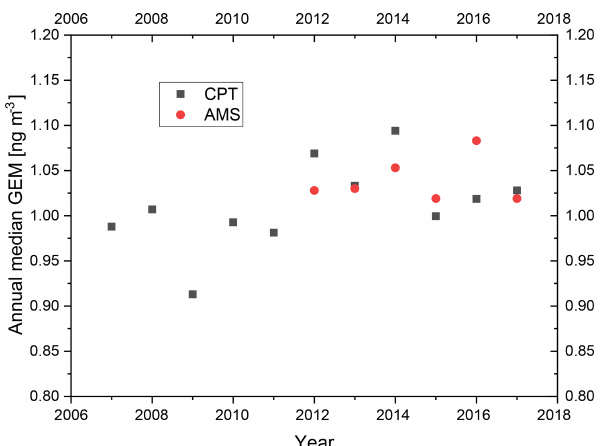
Figure 3. Annual median GEM concentrations at Cape Point (CPT) from March 2007 until December 2017 and at Amsterdam Island (AMS) from February 2012 until December